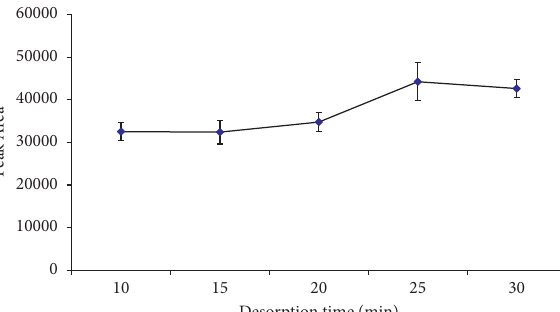
Figure 8: Effect of desorption time on desorption efficiency. Extraction conditions: extraction time 20 min with 0.01 M sulfuric acid as the desorption solvent and sample volume 5 mL; no adjustment of sample pH.